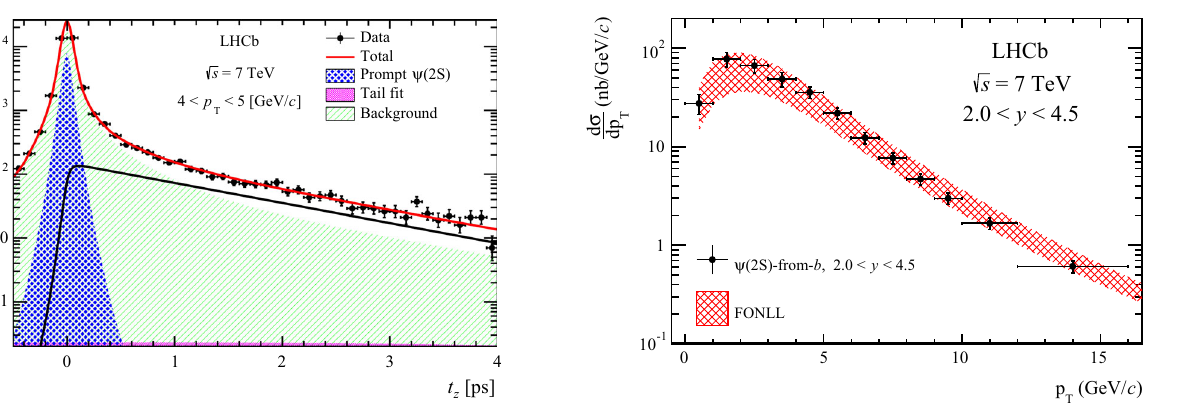
Fig. 8 Differential production cross-section of ψ( 2 S ) from b hadrons asafunctionof p T intherange2 . 0 < y < 4 . 5.Theresultsarecompared with the FONLL calculations [5]. The error bars include statistical and systematic uncertainties added in quadrature